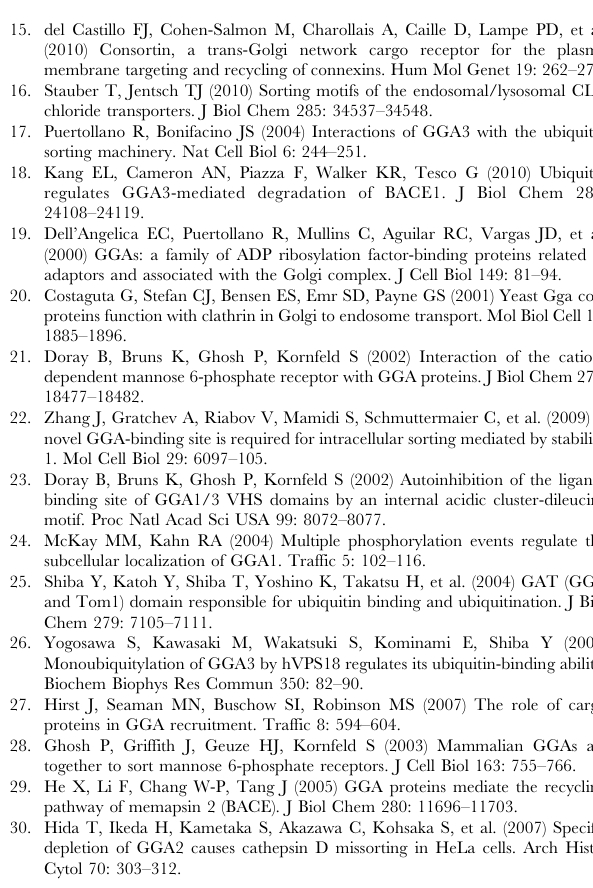
B1 corresponds to wt Gga2 mRNA, while B2 corresponds to Gga2 exon-1 spliced to the b -gal exon. Figure S2 Analysis of p56 in Gga null mice. A. Analysis of p56 in Gga1 , Gga3 and Gga1/3 brains of adult mice. 25 m g of total protein from whole brain lysates was resolved by SDS-PAGE, transferred to nitrocellulose and probed with anti-p56 rabbit polyclonal antibody made against the synthetic peptide described by Mardones et al. [31] and custom-synthesized for us by Covance. GAPDH was detected with an anti-GAPDH mouse monoclonal antibody. B. Analysis of p56 in Gga2 (TIGM) brains of day 1 pups. Samples were prepared and analyzed as in A. Figure S3 Low expression of GGA2 in mouse and human adult brain. A. Comparison of GGA2 expression between mouse adult brain and primary dermal fibroblasts shows greatly diminished level in brain. In contrast, GGA1 is expressed well in both tissues while GGA3 shows high expression in brain but extremely low level in fibroblasts. The absence of the GGA2 signal in fibroblasts derived from the single surviving Gga2 null mouse demonstrates the specificity of the signal. B. Similar to mouse, the level of GGA2 expression is below the detection limit in human adult brain. However, it is also quite low in fibroblasts, but readily detected in HEK 293 and Hela cells. In contrast, GGA1 and GGA3 are expressed at good levels in all four tissues/ cell-types examined.